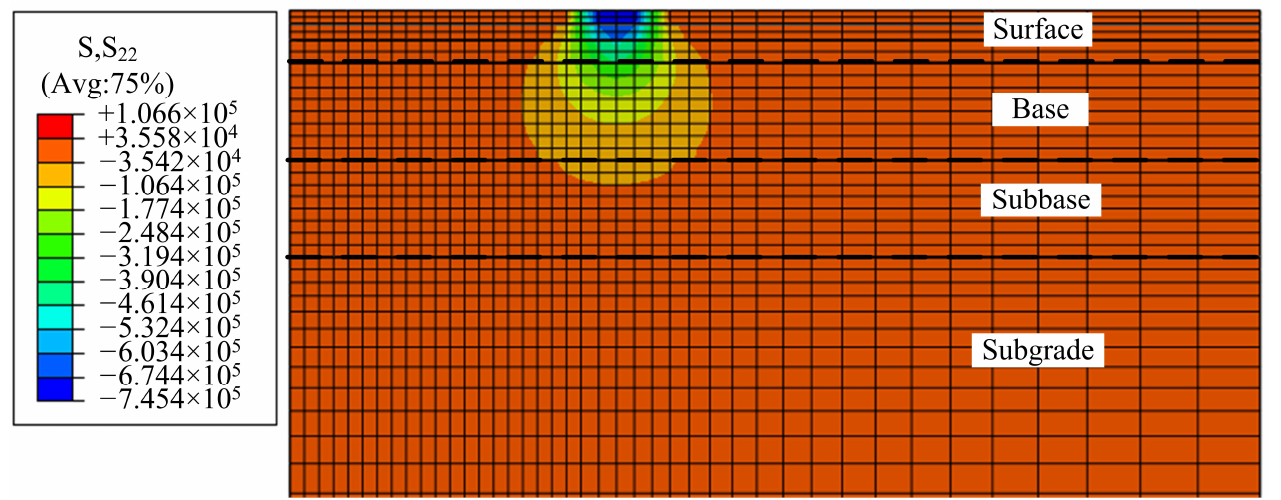
Figure 8. Vertical stress in middle section when load moves over it at initial speed of 10 km/h.